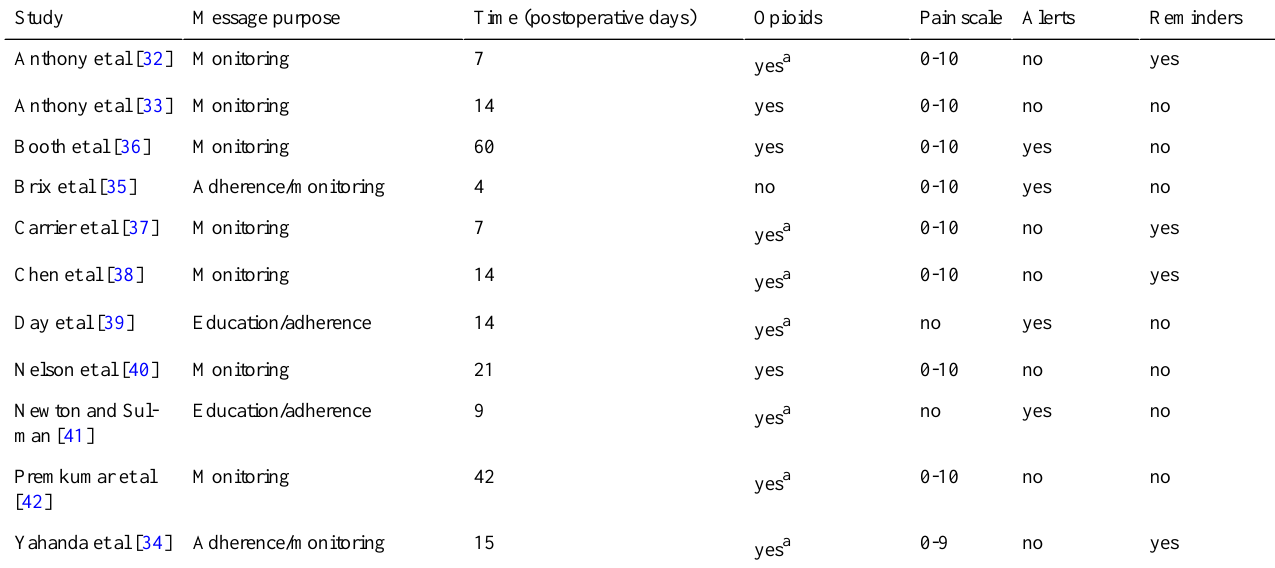
Table 2. Overview of the